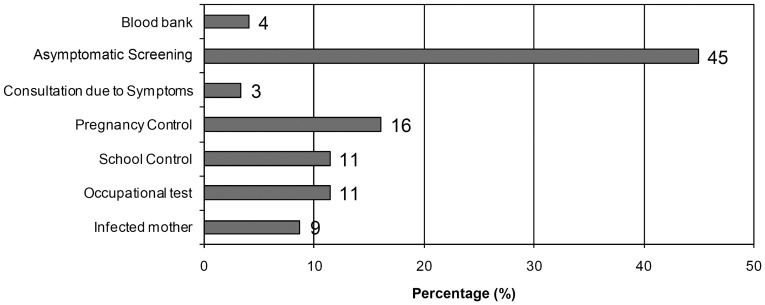
Method for detection of T. cruzi infection in 144 mothers.